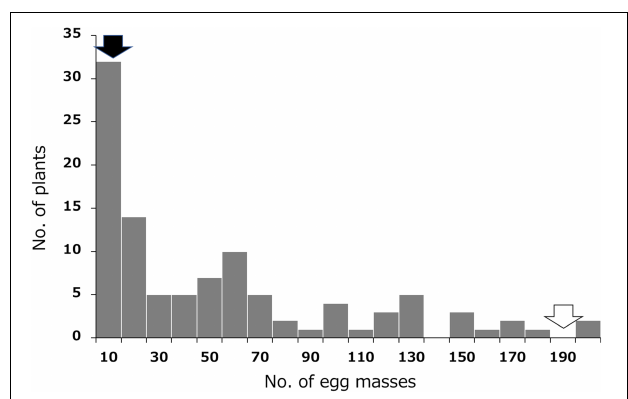
FIGURE 1 | Frequency distribution for the mean number of SP2 Meloidogyne incognita egg masses in the F 1 population derived from a cross between resistant “J-Red” and susceptible “Choshu” sweetpotato cultivars. Black and white arrows indicate the values of J-Red and Choshu,